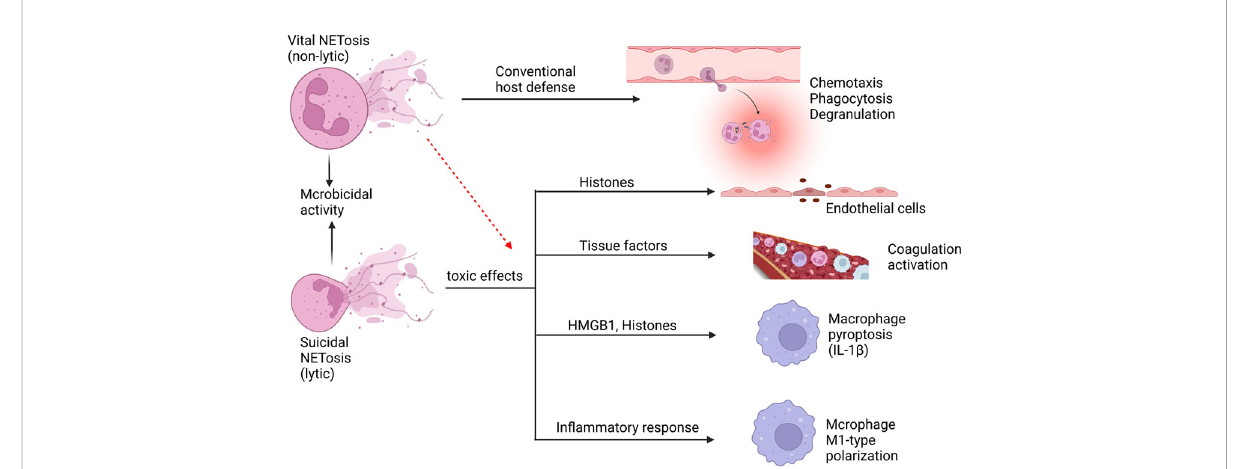
FIGURE 5 Neutrophil NETosis in sepsis. Suicidal NETosis and vital NETosis are two types of NETosis that differ mainly in whether or not the neutrophils cleave. The primary function of vital NETosis is to offer extracellular antimicrobial effects, ensuring that neutrophils remain mobile and phagocytic, but too much NET release also cause injury. Suicidal NETosis primarily causes some damage to the body, but also provides microbicidal activity. NETs and their components, such as histones and DNA, are cytotoxic and have the ability to damage endothelial cells. Tissue factors can be created and released during the creation of NETs, triggering the coagulation cascade while also boosting platelet activation, resulting in platelet aggregation and ultimately inducing thrombosis formation. NETs may induce macrophage pyroptosis, which will aggravate the in fl ammatory responses during sepsis. In addition, NETs may induce M1-type polarization of macrophages of lung tissue, which increases lung in fl ammation and lung